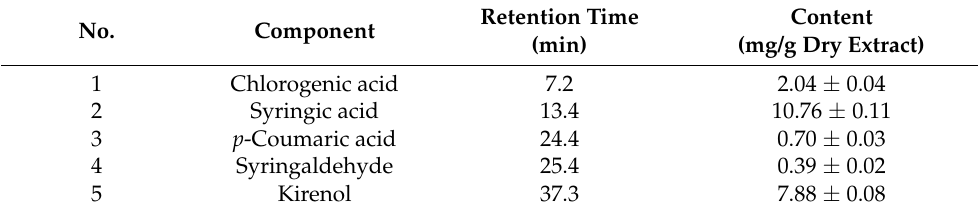
Figure 6. Main ingredients analysis of the SOE by HPLC. Peak 1: chlorogenic acid; peak 2: syringic acid; peak 3: p -coumaric acid; peak 4: syringaldehyde; and peak 5: kirenol. The analyses were performed by a Supelco C18 column, and a gradient of acetonitrile and 0.1% acetic acid was used as the mobile phase. The compounds were identified with those of reference compounds. Table 1. Content of the main ingredients in SOE